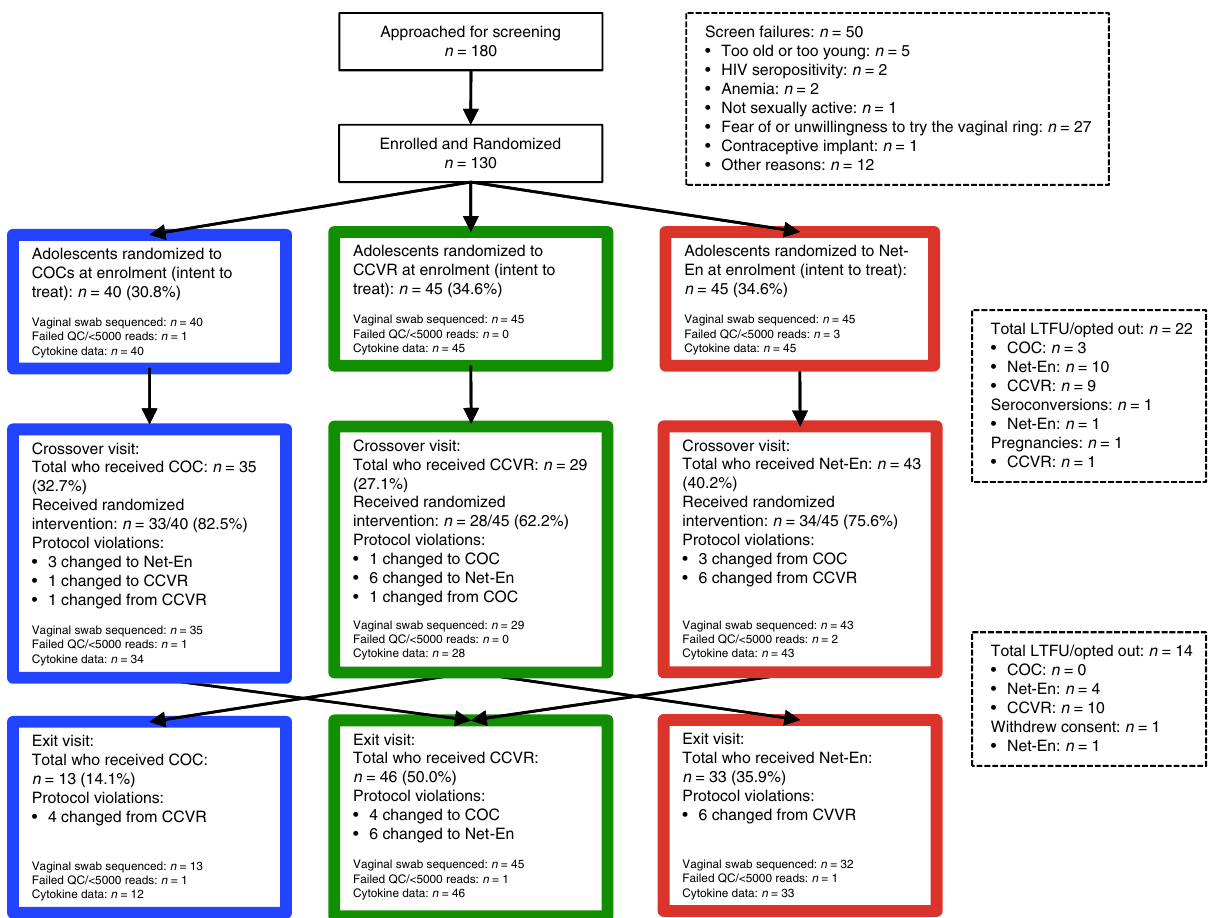
Fig. 1 Study overview and randomization. CONSORT diagram of the number of participants that completed each study visit and provided genital samples, and the distribution of participants on each of the hormonal contraceptive methods analyzed: combined oral contraceptives (COC), the Net-En injection, and the vaginally inserted combined contraceptive ring (CCVR) at crossover and exit. Note that at crossover, some participants could choose their next contraceptive method if assigned to CCVR as their fi rst method. LTFU